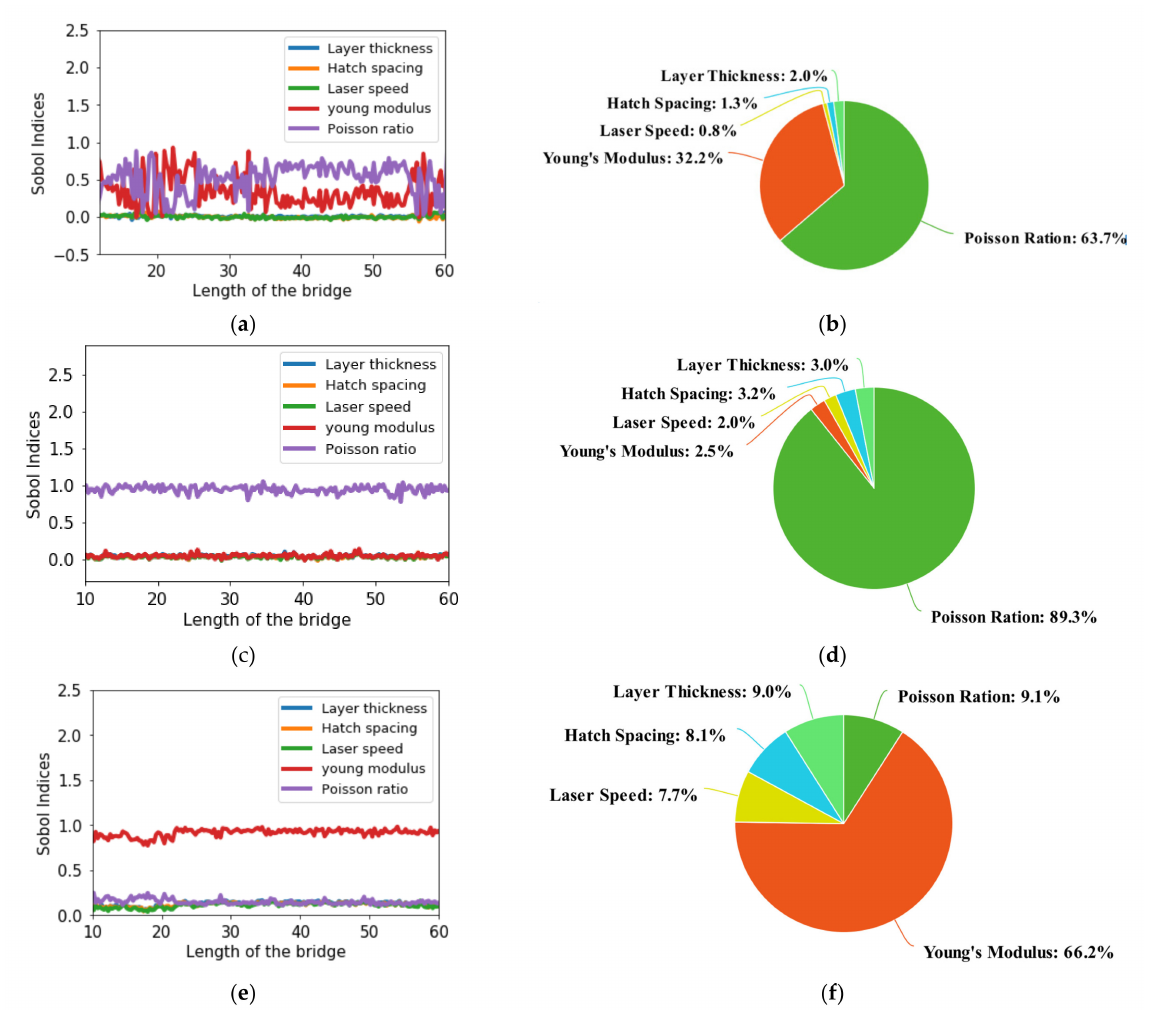
Figure 19. Variation in sensitivity indices along the length of the bridge (x-direction) at z = 9.536 are presented in ( a , c , e ) for the x, y, and z-directional strains, respectively. Whereas the ( b , d , f ) represents the importance of each parameter in a percentile form for x, y and z directional strains